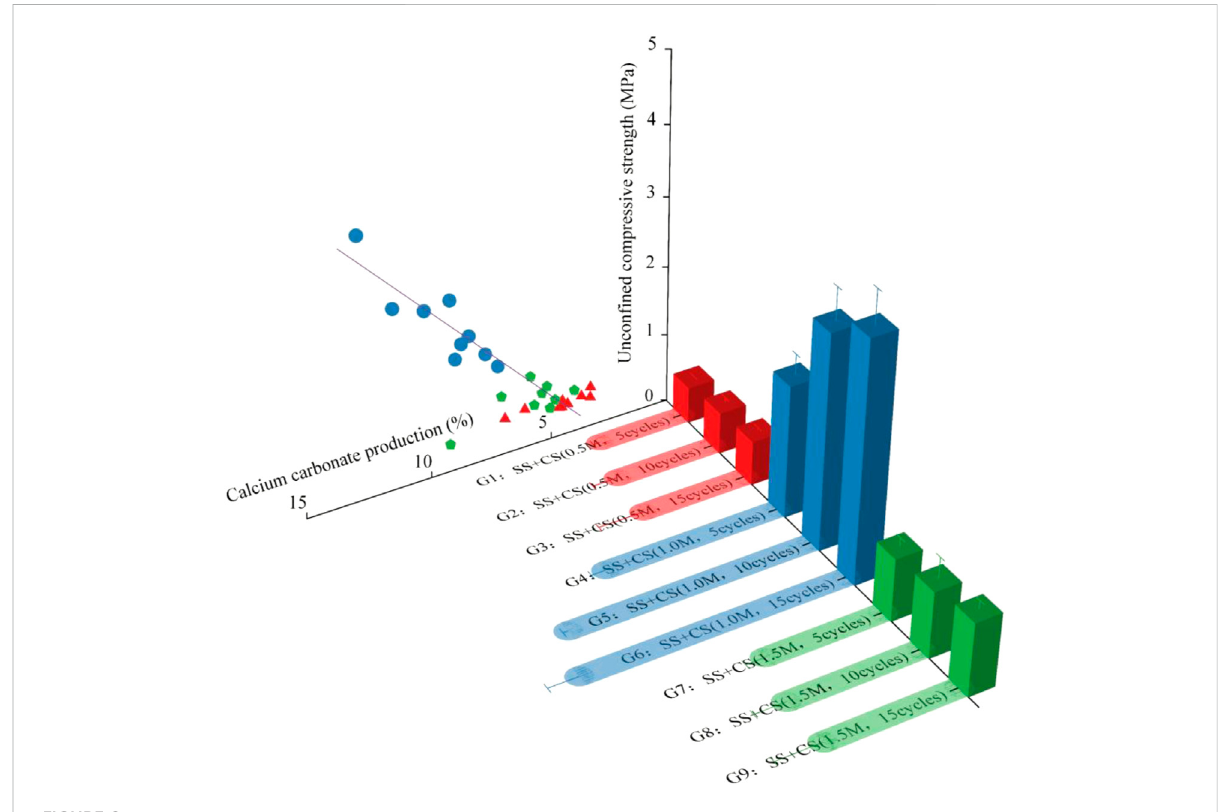
FIGURE 8 Relationship between calcium carbonate content and uniaxial compressive